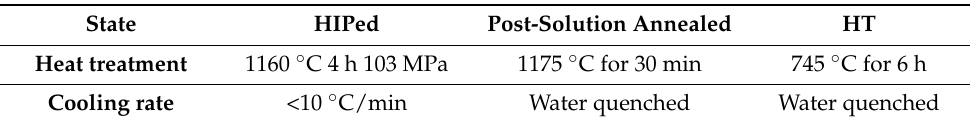
Table 1. Three post-processed conditions investigated: hot isostatic pressed (HIPed), post-solution annealed, and heat-treated